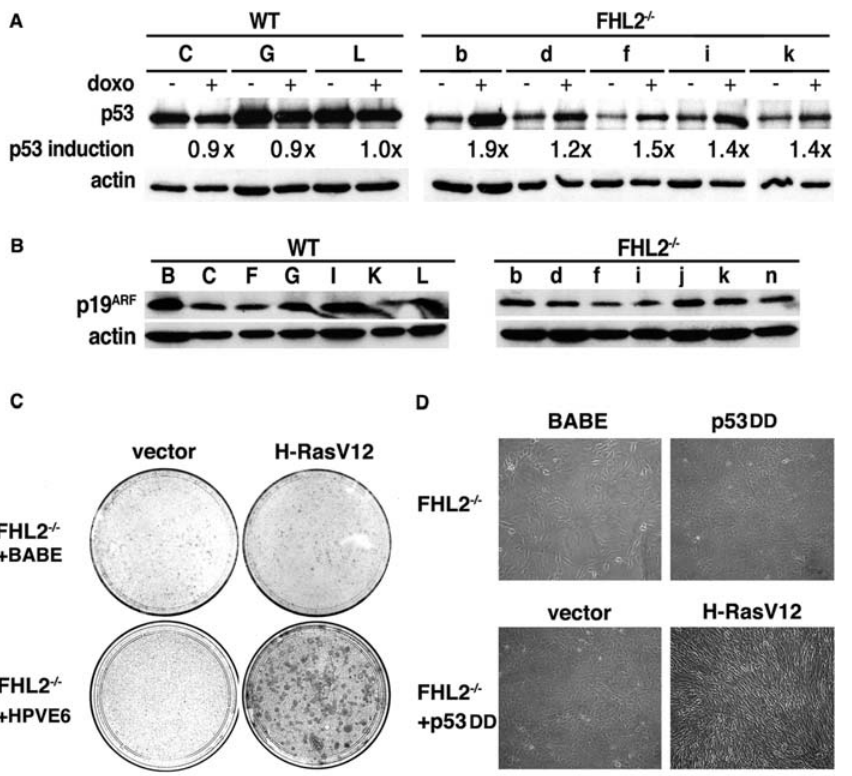
Figure 3. Analysis of the p53/ARF pathway in immortalized FHL2 2 / 2 MEFs. (A) Functional analysis of the p53 protein. After induction by doxorubicin (doxo), p53 was immunoprecipitated from immortalized MEFs and analyzed by immunoblotting. Wild type clones are indicated by capital letters and FHL2 2 / 2 clones by lower-case letters. p53 induction was determined as the ratio of the relative p53/actin intensities after doxo treatment to p53/actin intensities without doxo in each cell line. (B) Western blot analysis of p19 ARF expression in seven immortalized clones of each FHL2 genotype. (C) Human papillomavirus E6 oncoprotein restores Ras-mediated transformation in immortalized FHL2 2 / 2 MEFs. Cells were infected with E6-expressing retrovirus (HPVE6) or control virus (Babe), and then transiently transfected with H-RasV12 plasmid or control vector, cultured for 3 weeks without splitting and stained. Data are representative of three independent experiments in two independent E6-transduced FHL2 2 / 2 MEF clones. (D) Dominant negative p53 (p53DD) was expressed alone or coexpressed with H-RasV12 by retroviral vectors in immortalized FHL2 2 / 2 MEFs.